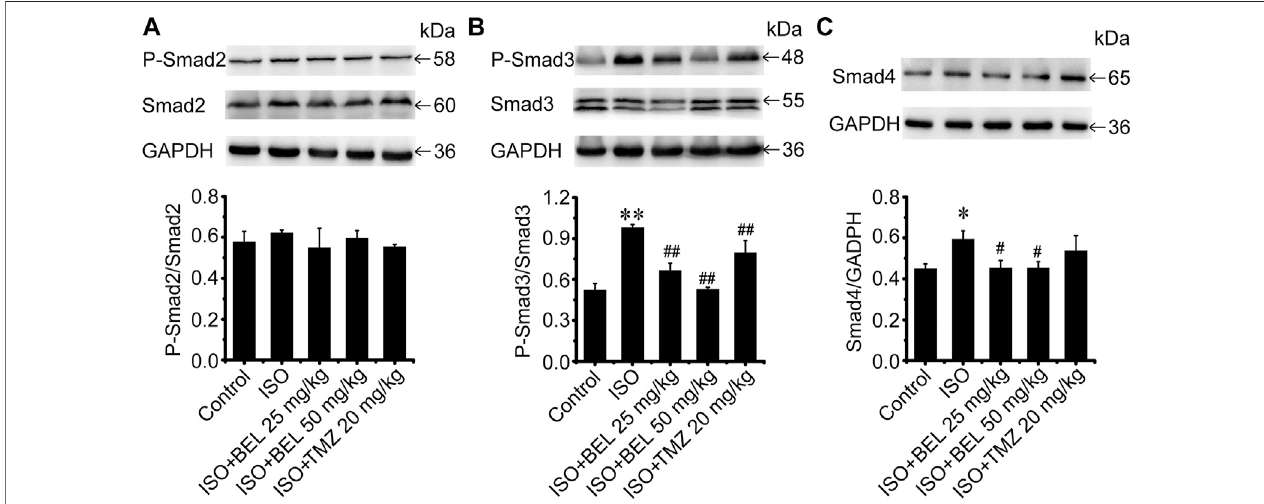
FIGURE 8 | BEL regulates Smad proteins expression and phosphorylation in vivo (A – C) Western blotting analysis of Smads2, 3, 4 expression and Smads2, 3 phosphorylationlevels. BargraphsshowfoldchangesofP-Smad2/Smad2, P-Smad3/Smad3andSmad4/GAPDH( n (cid:2) 3).Datawereshownasmean ± SEM.* p < 0.05 vs. control, ** p < 0.01 vs. control, # p < 0.05 vs. ISO, ## p < 0.01 vs. ISO.